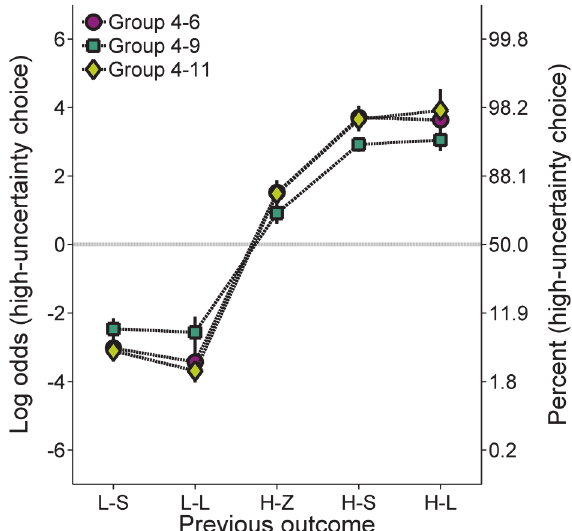
Fig 5. Mean ( ± SEM) log odds of high-uncertainty choices for each group in Experiment 2 as a function of the outcome of the previous choice, collapsed across the probability of high-uncertainty food delivery. A second ordinate showing percentages corresponding to the log odds values was included to aid interpretation. L-S = low-uncertainty-small; L-L = low-uncertainty-large; H-Z = high-uncertainty-zero; H-S = high-uncertainty-small; H-L = high-uncertainty-large.